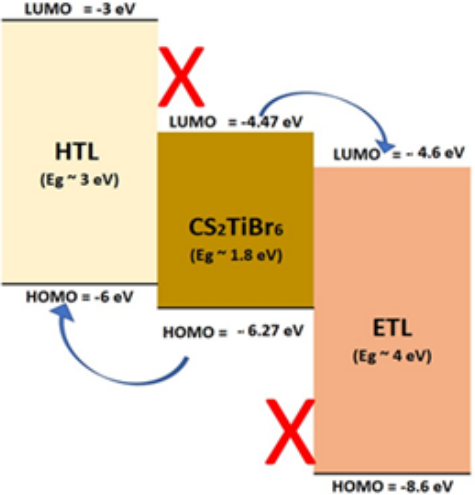
Figure 7. Energy level alignment for Cs 2 TiBr 6 cell with highly suitable band structure of hole transport and electron transport layer for an efficient photovoltaic response.